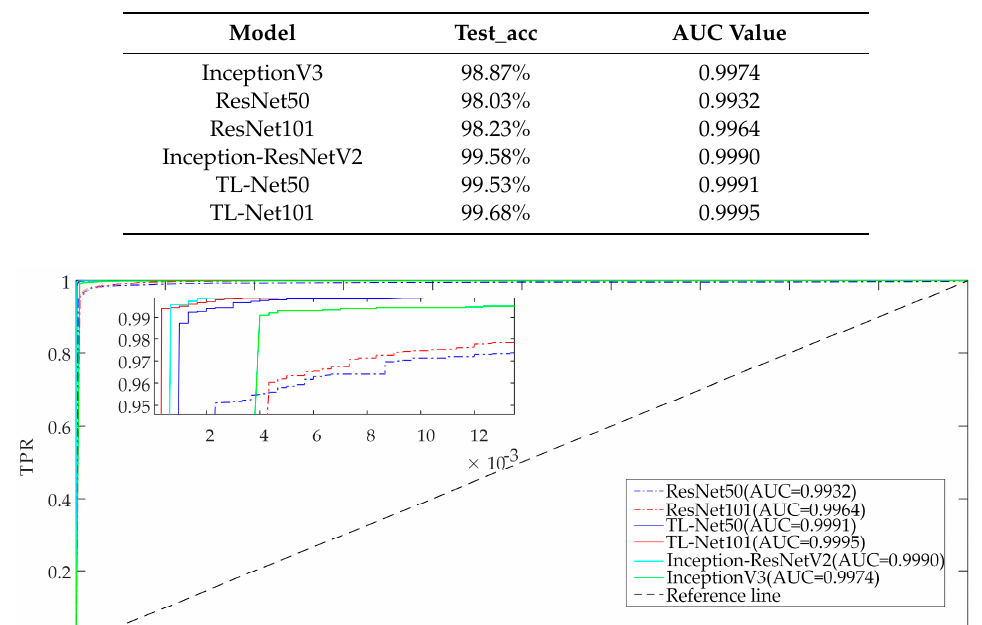
Figure 13. ( a ) The training accuracy curves of TL-Net101, InceptionV3, and Inception-ResNetV2; ( b ) the training loss curves of TL-Net101, InceptionV3, and Inception-ResNetV2. Table 3. The accuracy and AUC of some typical convolutional neural networks (CNNs) and TL-Nets. “Test_acc” denotes the test accuracy.